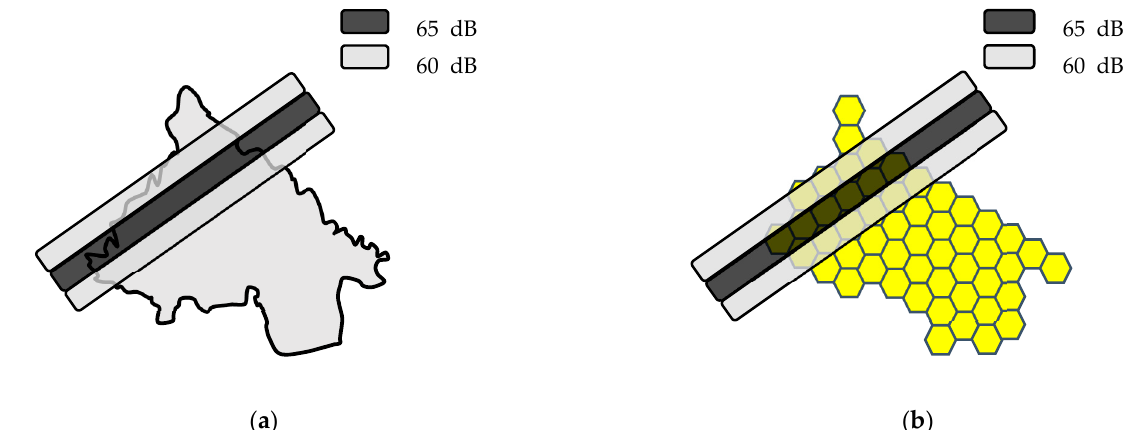
Figure 10. ( a ) Virtual noise width of eVTOL passing through the actual city; ( b ) virtual noise width of eVTOL passing through a virtual city modeled in an ideal space.